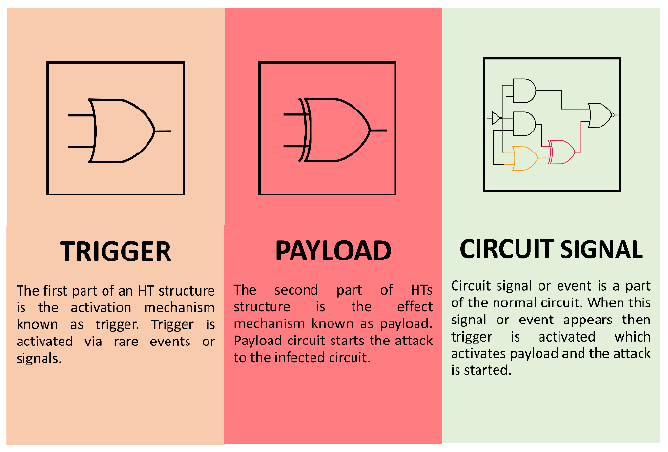
Figure 1. Hardware trojan structure.